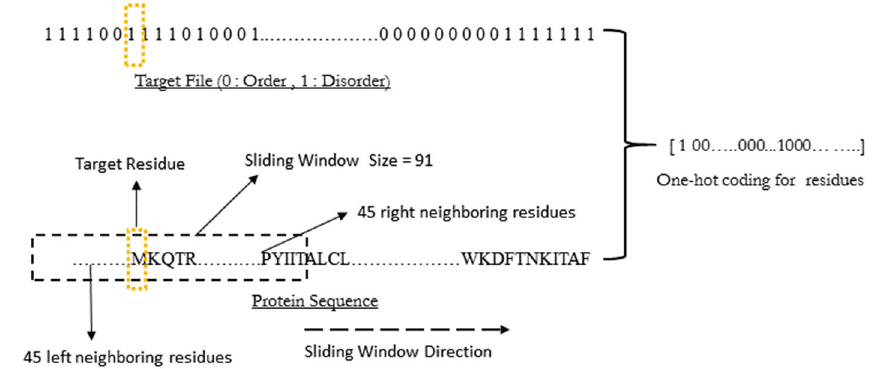
Figure 9. Wide windows used for sequence